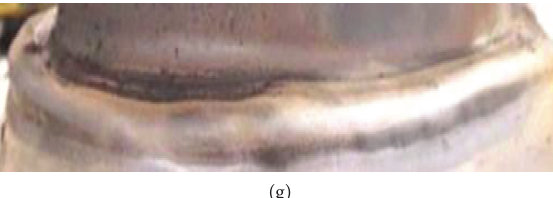
Figure 5: The profile and the orientation of the effective stress with the failed profile at the bottom interface of the whole buffer. (a) The effective stress profile of the bottom interface of the buffer. (b) The zoomed area of the hot spot at the bottom interface of the buffer. (c) The effective stress direction at the hot spot of the bottom interface in the YOZ plane ( − 16.4 ° from Z. (d) The effective stress direction at the hot spot of the bottom interface in the XOY plane (88.9 ° from X). (e) The effective stress direction at the hot spot of the bottom interface in the XOZ plane ( − 89.7 ° from X). (f) The hot spots at the bottom interface of the whole buffer. (g) The failed bottom interface of the whole buffer (debonding underneath).